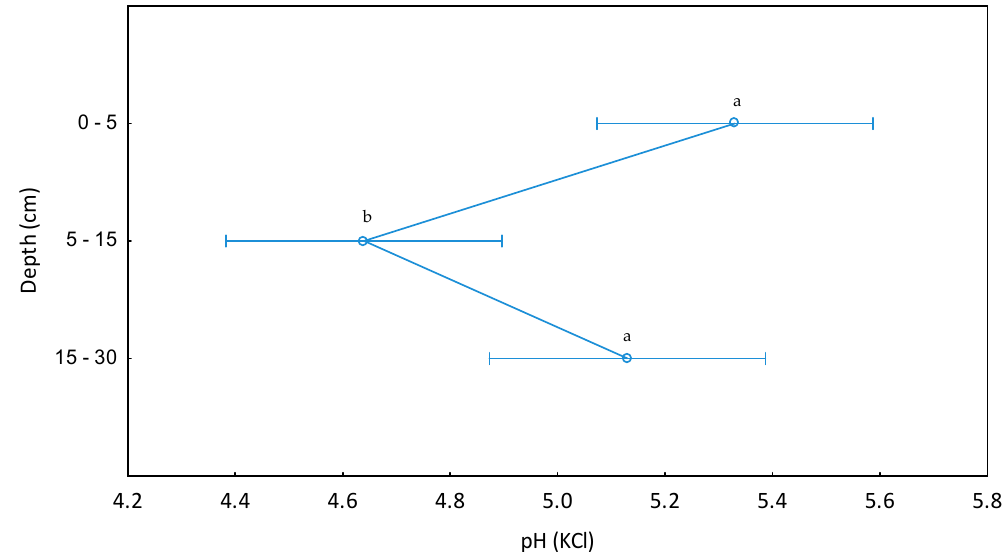
Figure 2. Stratification of pH (KCl) between 0–5, 5–15, and 15–30 cm soil depth of soils with at least one depth increment with pH (KCl) ≤ 5.0. No common superscript letter indicates a significant ( p ≤ 0.05) difference.